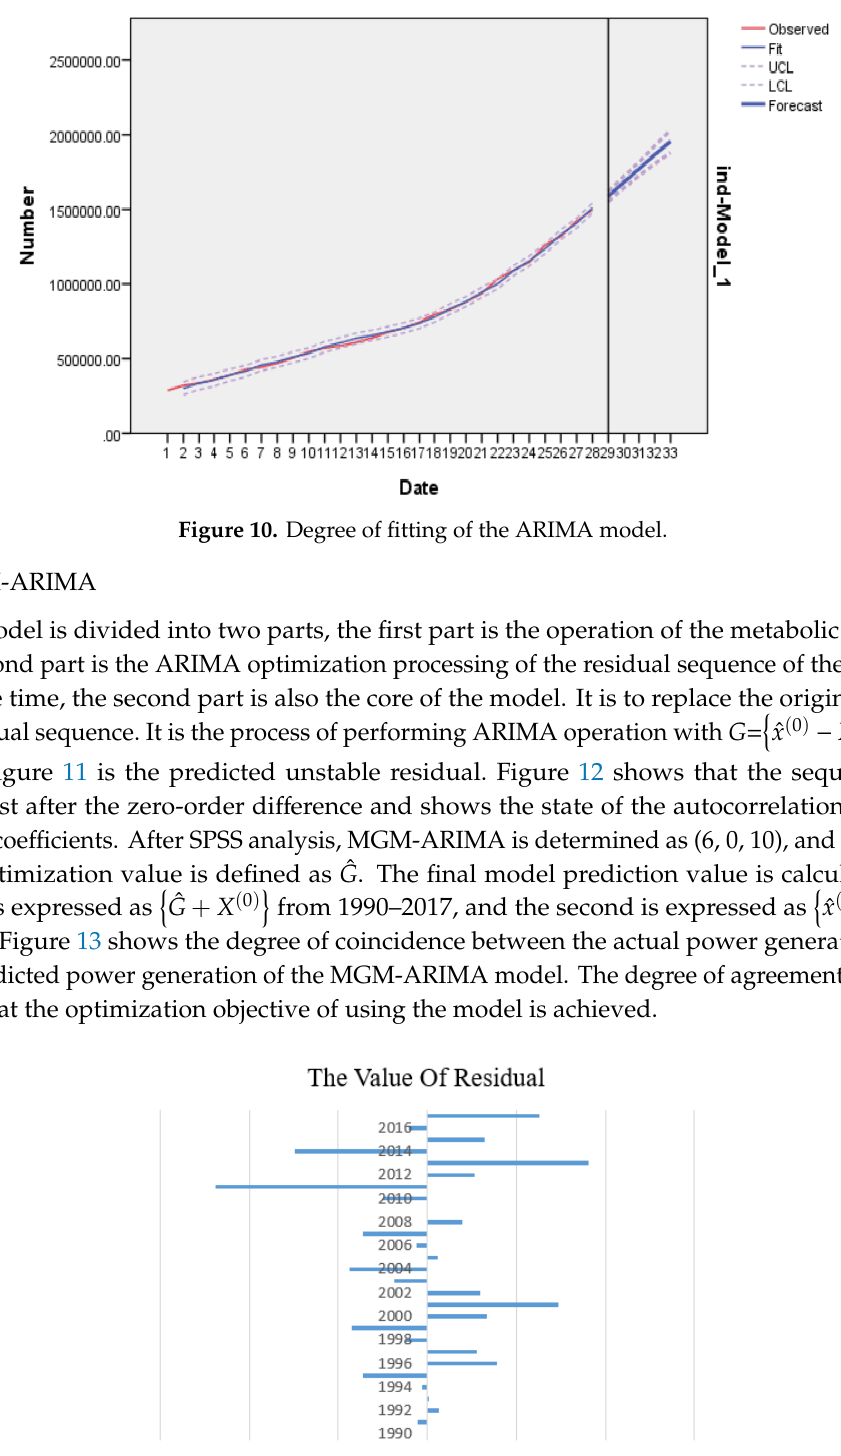
Figure 10. Degree of fitting of the ARIMA model. Table 3. The model statistics for ARIMA.